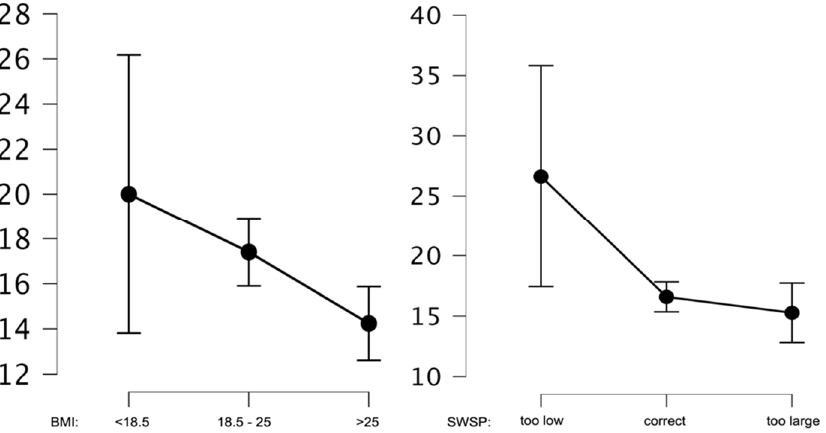
Figure 2. Average AGF values for BMI and SWSP.